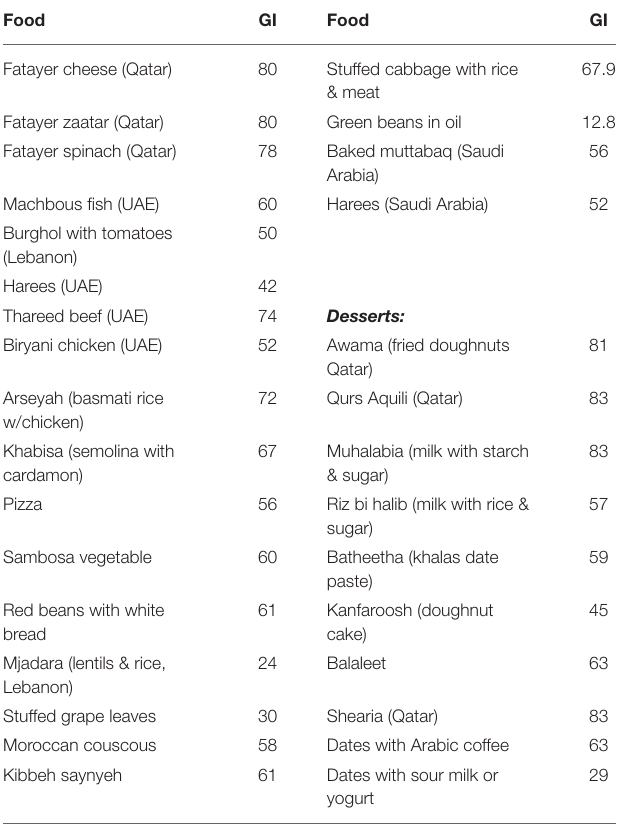
TABLE 5 | Glycemic index of common Middle Eastern dishes.